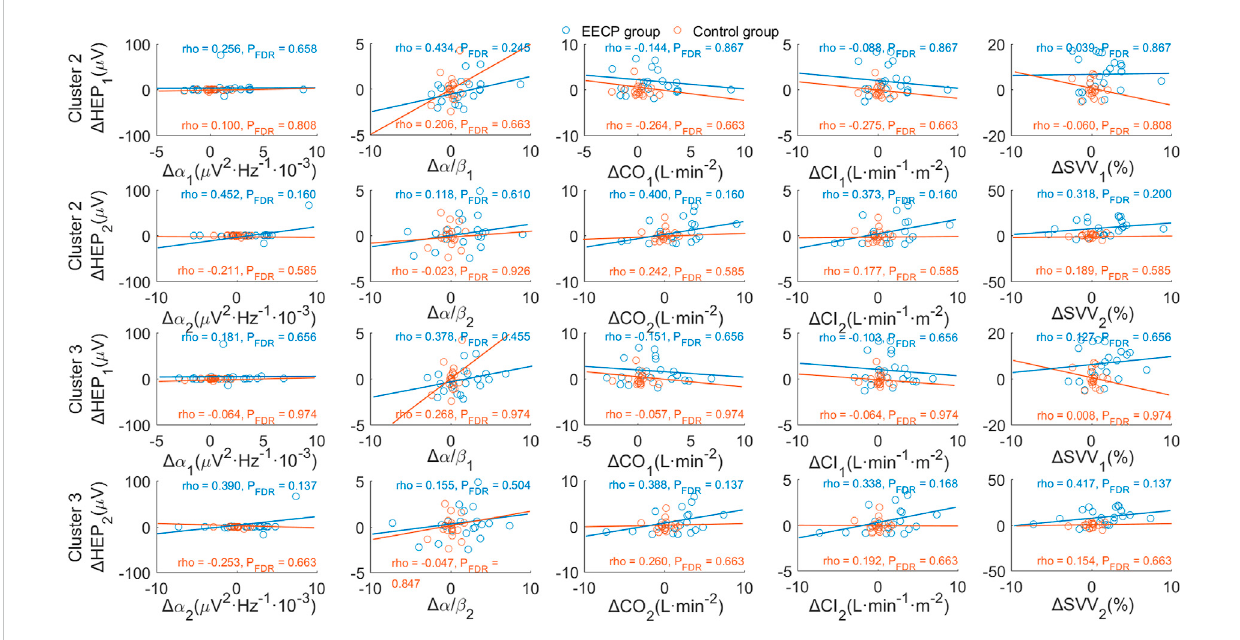
FIGURE 6 Correlation analysis of changes in HEP amplitude and variations of physiological parameters. p -values were calculated for Spearman ’ s correlation. The upper two panels show the association between Δ HEP of cluster 2 (354 ms – 389 ms after T-peak) and variations of signi fi cant physiological parameters for stages EECP-1 and EECP-2, respectively. Similarly, the lower two panels demonstrate the association between Δ HEP of cluster 3 (367 ms – 387 msafterT-peak)andvariationsofsigni fi cantphysiologicalparametersforstagesEECP-1andEECP-2,respectively. α ,Alphafrequency band of EEG (8 – 13) Hz; α / β , power ratio of Alpha and Beta frequency bands; CO, cardiac output; CI, cardiac index; SVV, stroke volume